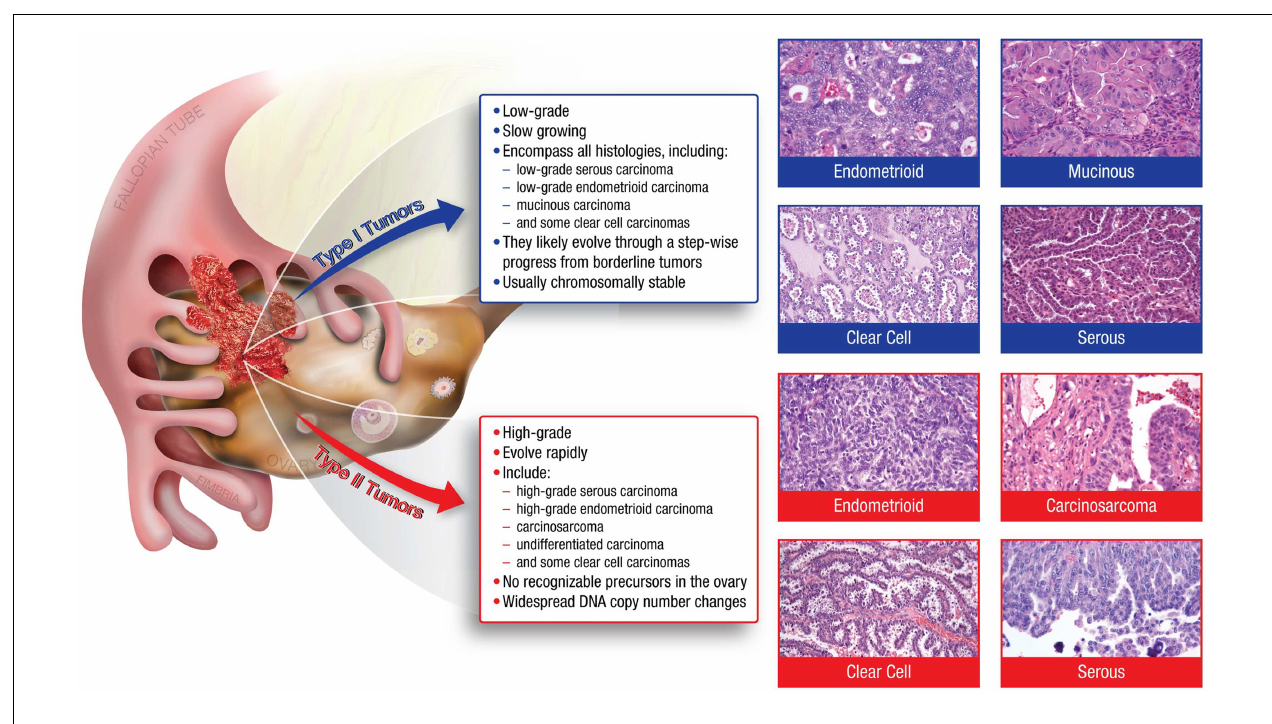
the ovarian surface epithelium, inclusion cysts, or endometriosis. In contrast,Type II tumors are high-grade and rapidly growing carcinomas. Typically, they have spread well beyond the ovary at the time of